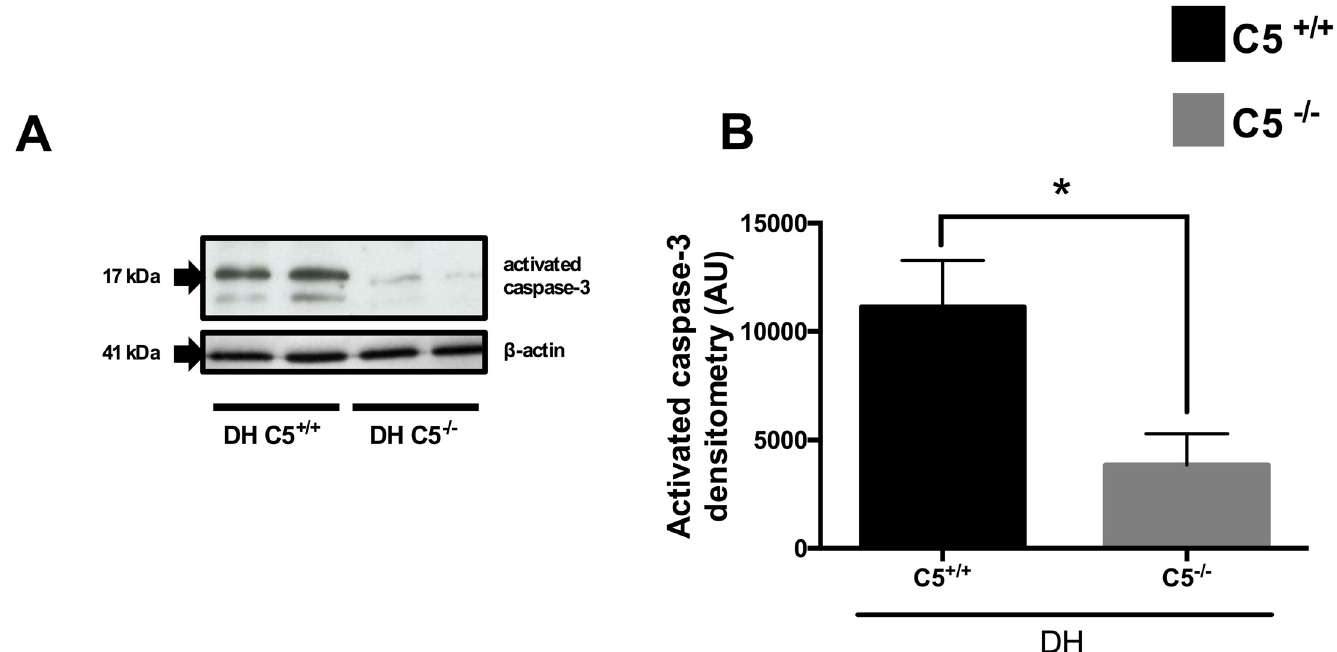
Fig 2. Activated caspase-3 in lung tissue in C5 +/+ , wt (black bar) or C5 -/- (grey bar) mice after sham procedure or double hit (DH). A . Representative western blot of activated caspase-3 in two wt and two C5 -/- mice after DH and corresponding western blot of anti- β -actin. B . Densitometry of three independent western blots for activated caspase-3. For each bar, n = 7 separate mice. * p < 0.05.